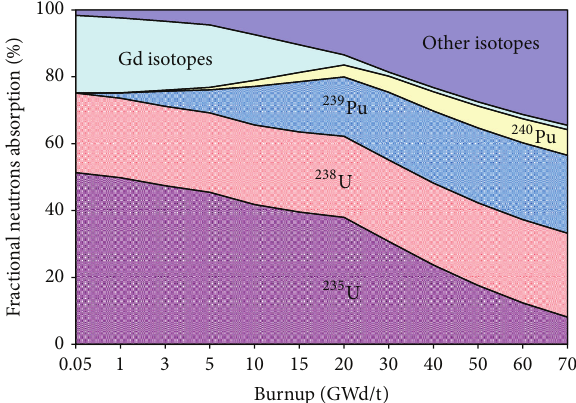
Figure 8: Fractional neutrons absorption in UO 2 fuel.